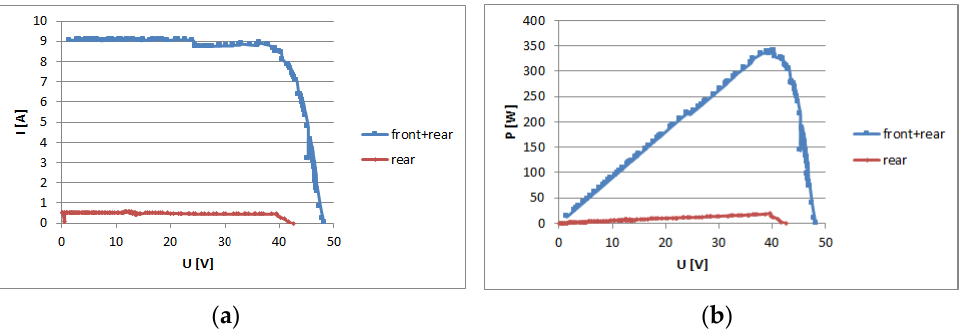
Figure 17. The whole vs. rear side yield characteristics benchmark in a bifacial module: ( a ) current- voltage characteristics; ( b ) power-voltage characteristics for 60° inclination over the foil substrates.